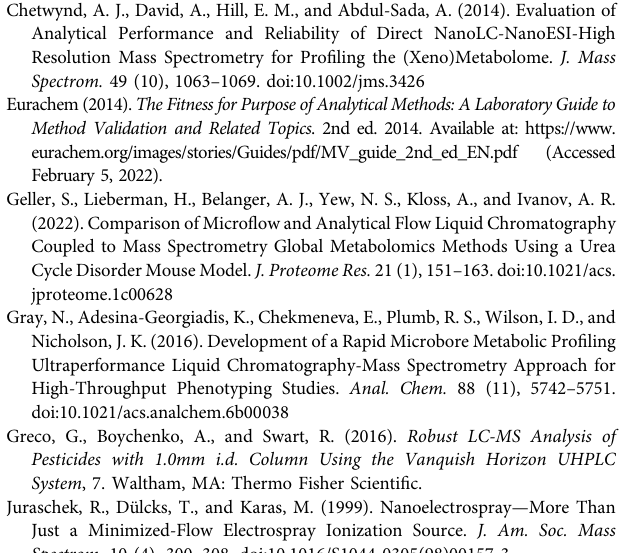
for all other molecules. Molecules are ordered by retention time (top left: lower rt, bottom right: higher rt). Sulfonamides/sulfonate, nitrates, and thiophosphates are marked with (*). Supplementary Figure S2 | Limit of detection obtained for test compounds spiked to plasma extract based on area standard deviation of N = 4 repeated injections at the lowest concentration in the linear range. Calculation is described in the main text. Sulfonamides/sulfonate, nitrates, and thiophosphates are marked with